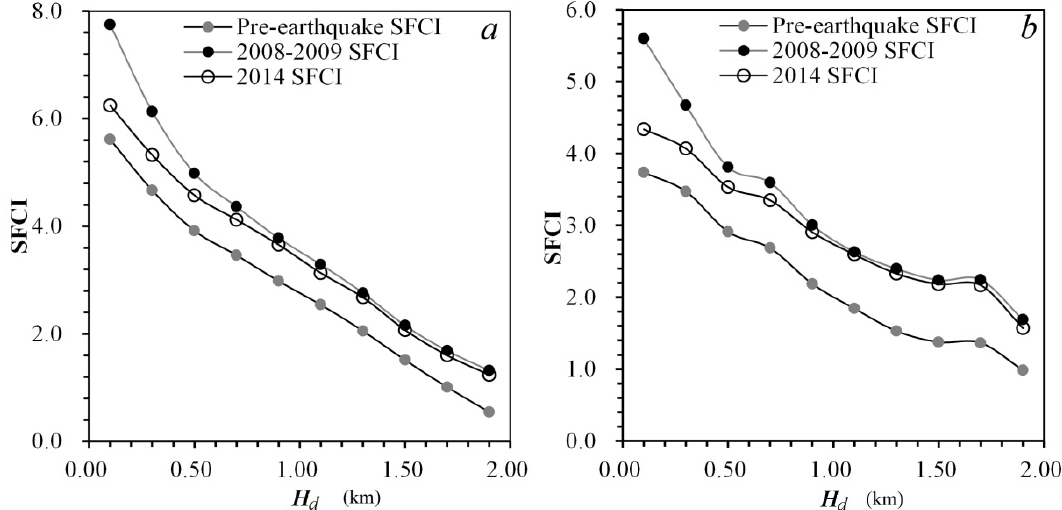
Figure 10. SFCI change processes before and after the earthquake